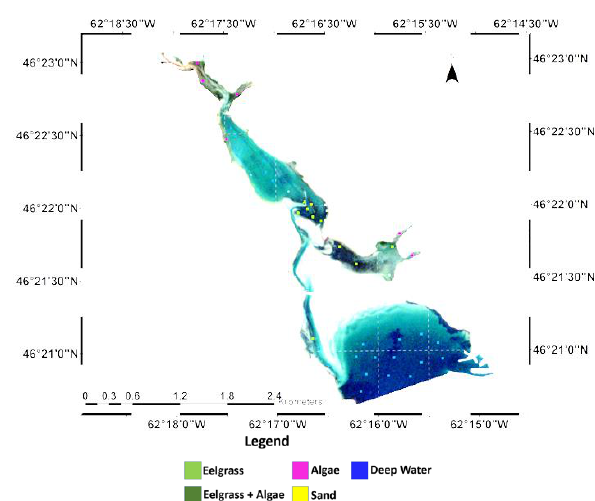
Figure 5. Distribution of training areas used in the Sentinel-2